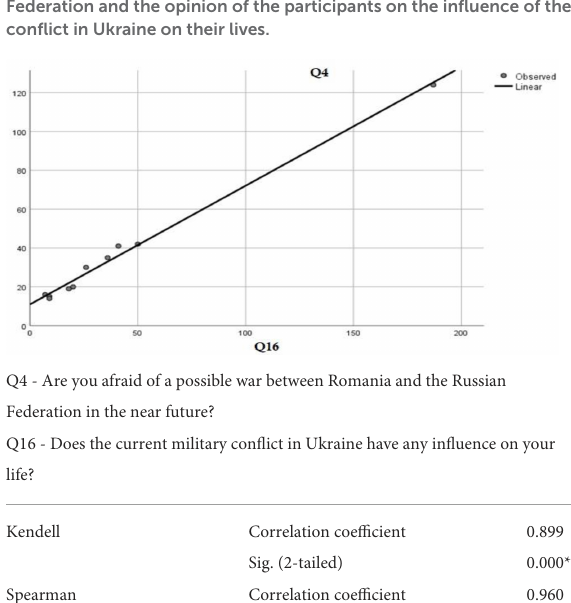
TABLE 13 Correlation of answers with 4 and 5 to the questions concerning the fear of a future war in Romania and the Russian Federation and the opinion of the participants on the influence of the conflict in Ukraine on their lives.